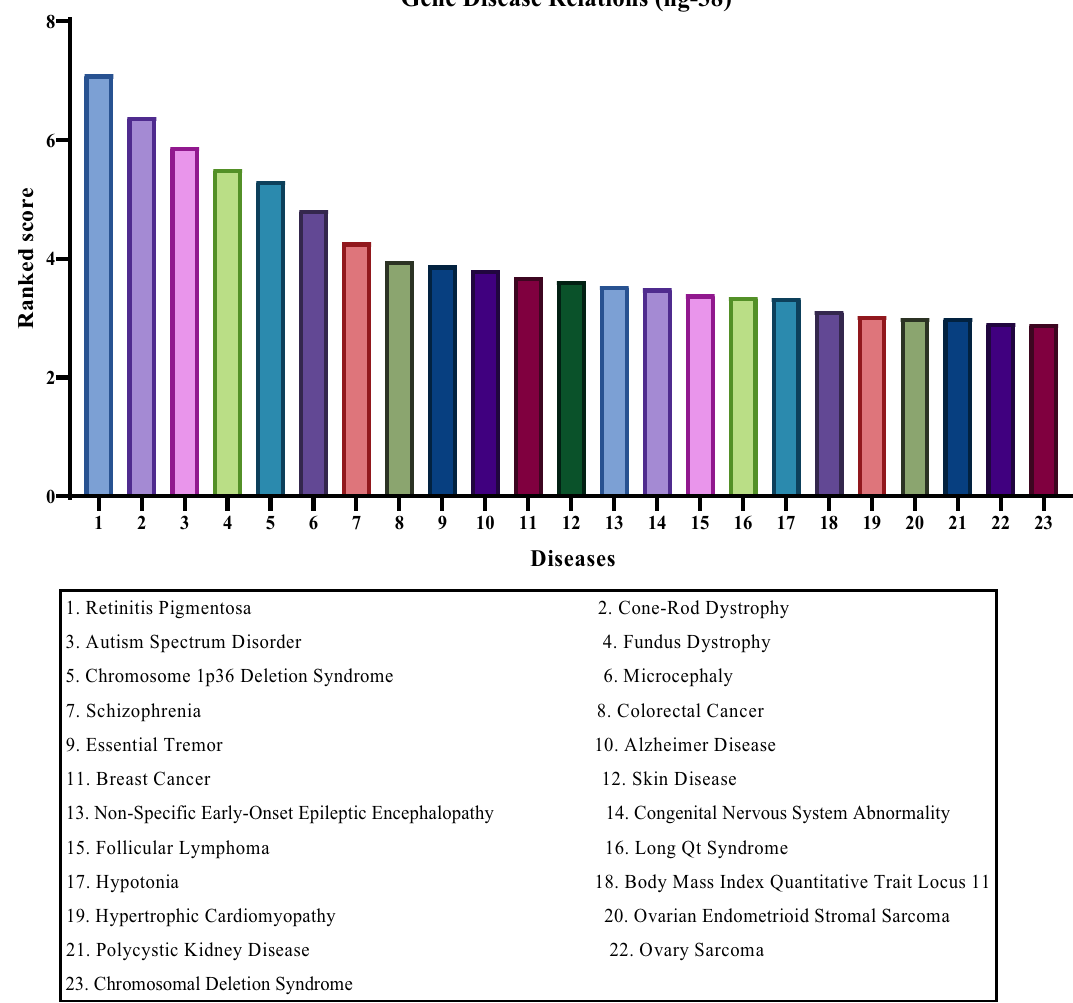
Fig. 5 Mural and Cumulus Granulosa Cell Gene Disease Relations (hg-38). Results from GeneAnalytics (connected to the MalaCards system) reveal the genetic links between Mural and Cumulus-related diseases